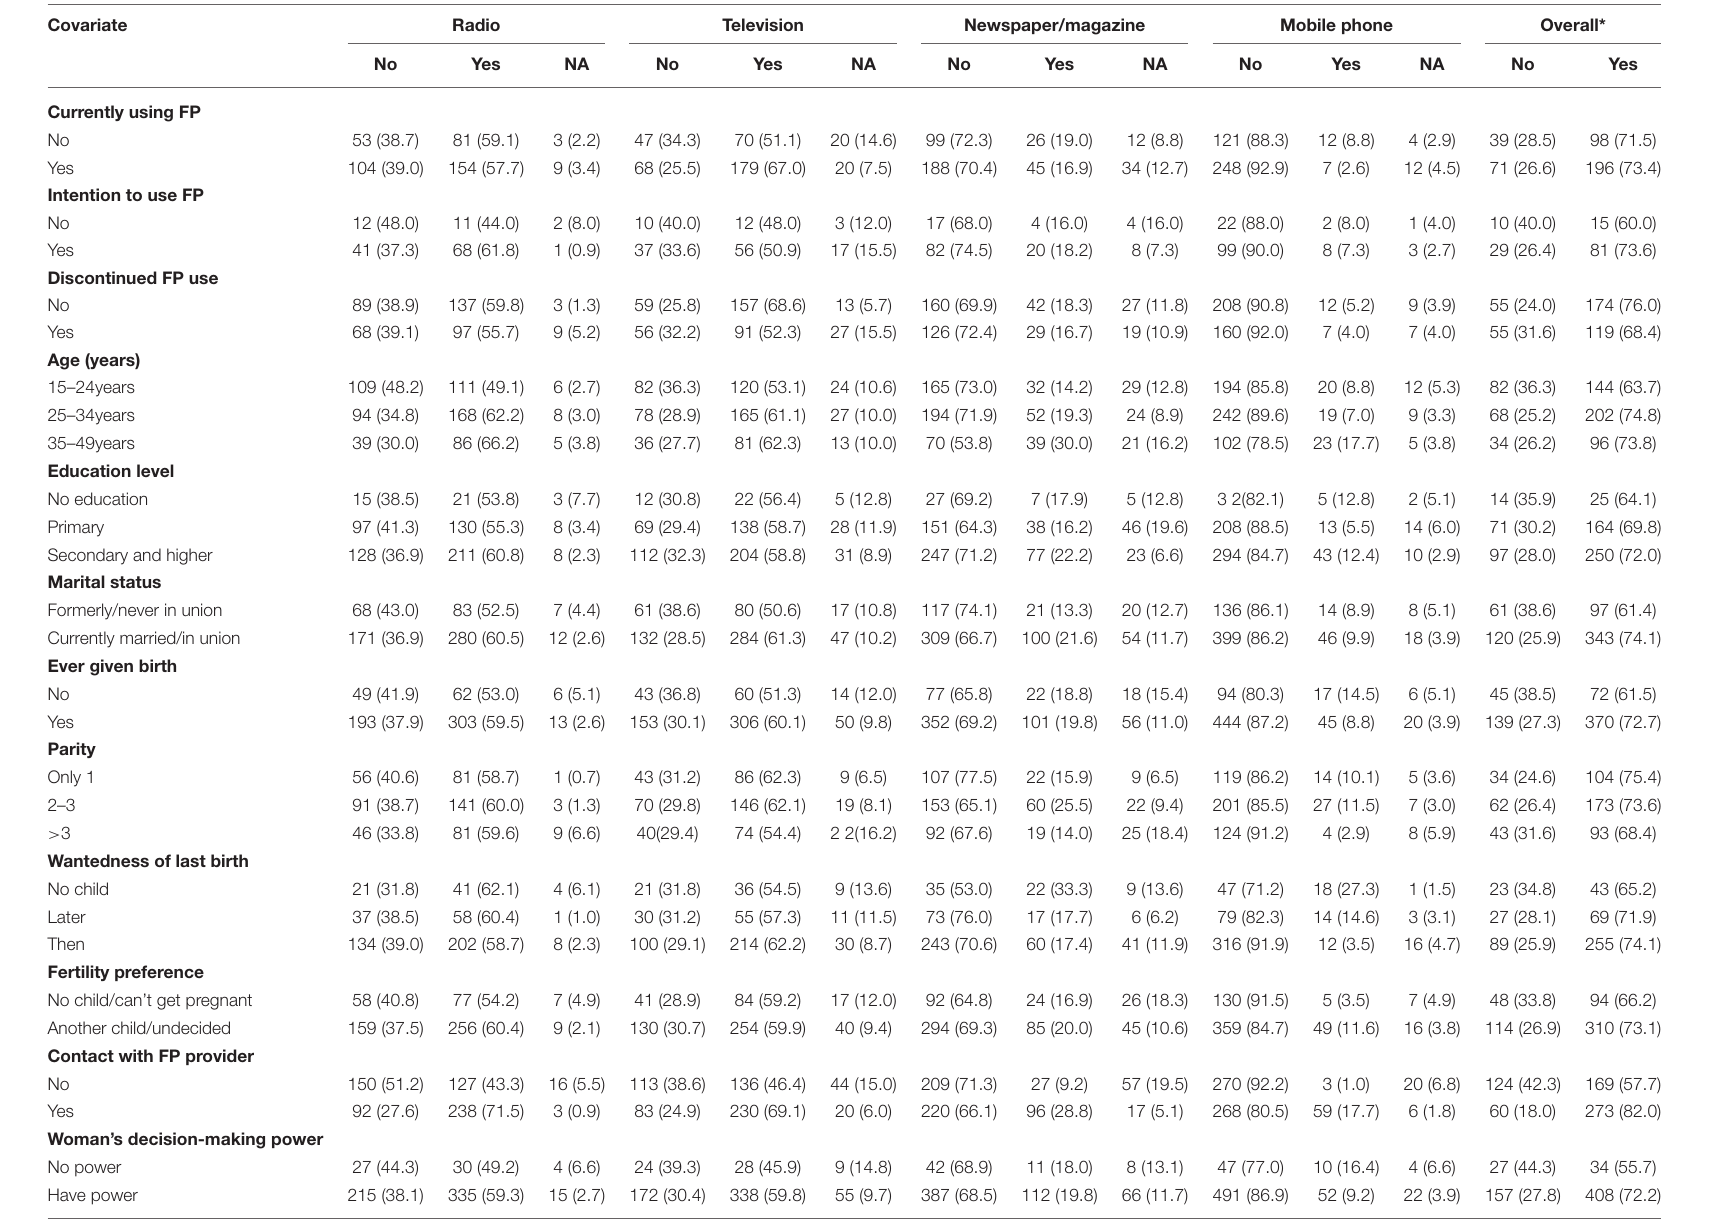
TABLE 3 | Exposure to FP information by channel and respondent characteristics.